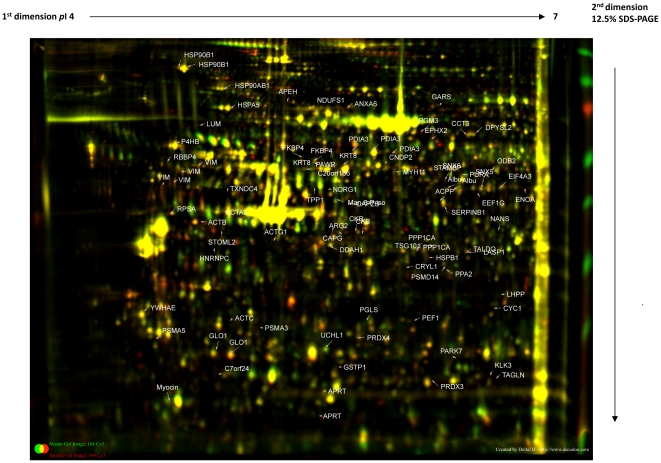
Representative 2-DE proteome map of prostate tissue from tumor vs. benign samples.Proteins were resolved by IEF over the pI range 4–7, followed by 12.5% SDS-PAGE and overlaid by Delta2D. After extraction from tissues, proteins were labeled with Cy3 and Cy5. An internal standard comprised of equal amount of proteins from all samples (benign and PCa groups) was labeled with Cy2 and included in all gels. The green spots indicate downregulated proteins, while the red spots indicate upregulated proteins in PCa relative to the corresponding benign tissue. The identified proteins that showed significantly altered expression in the PCa are indicated with arrows and labeled with the respectives protein IDs.